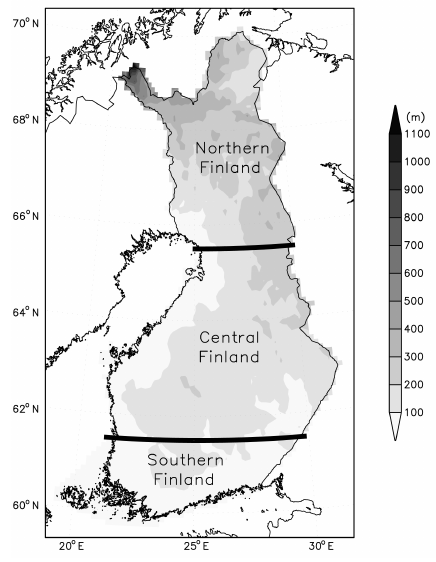
Figure 3. Division of Finland into southern, central and northern Finland. Shading shows the elevation above mean sea